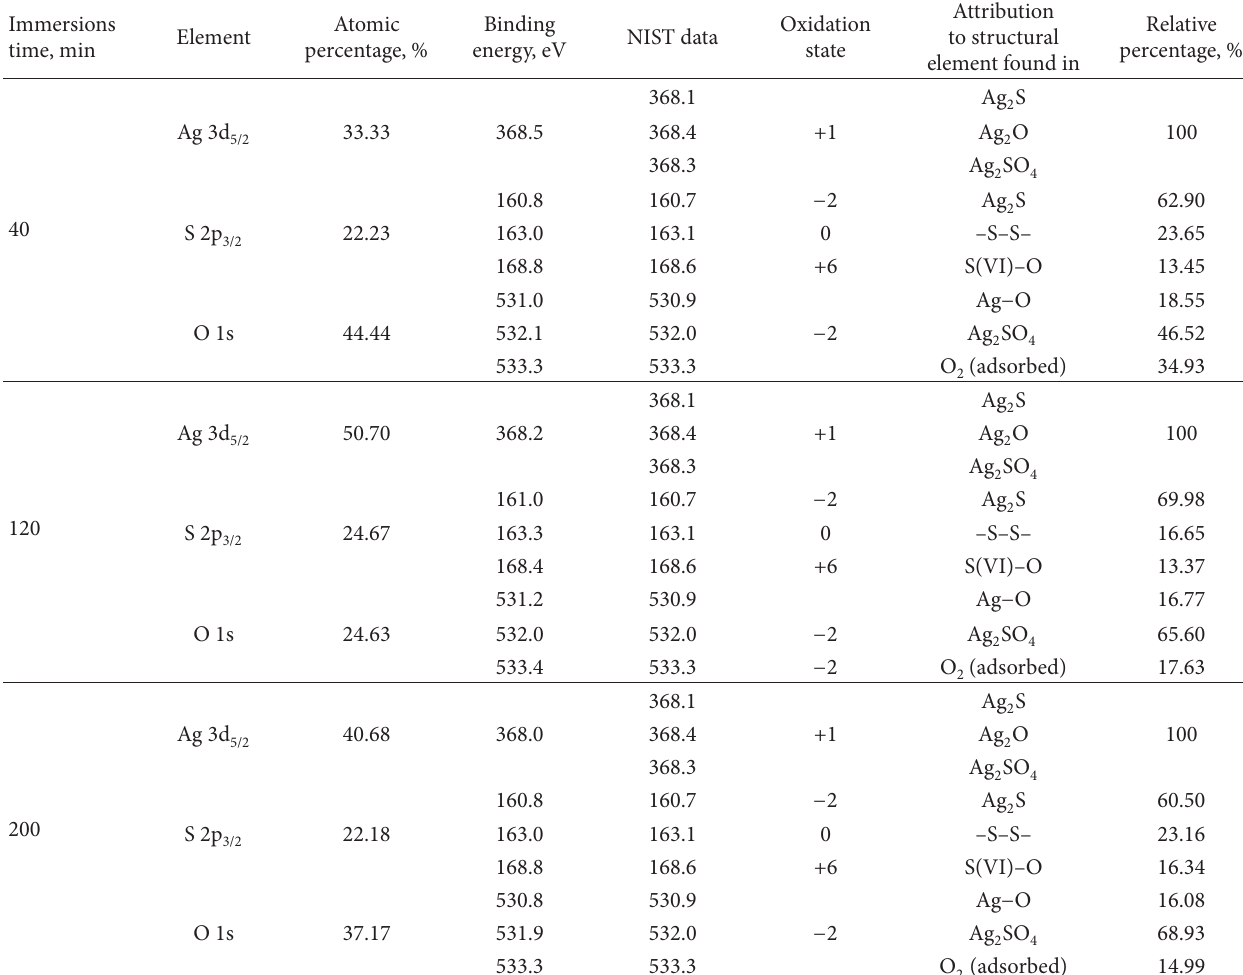
T 2: XPS results derived from the curve �tted deconvoluted